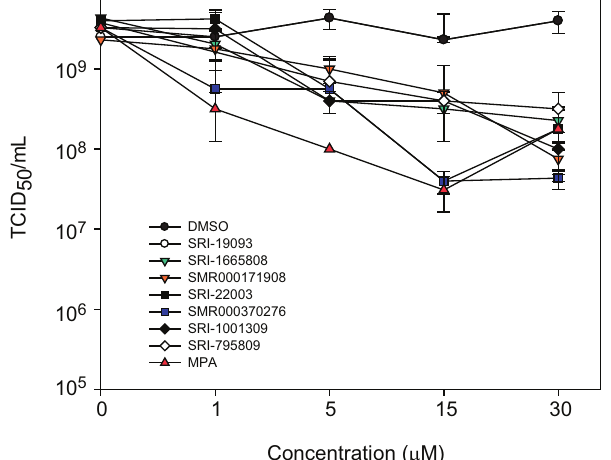
Figure 5. Titer reduction assay in a dose response format. Virus was grown in the presence of compound and then harvested 48 h post-infection. Virus titer was measured as TCID /mL. Each data point represents the mean from experiments performed in 50